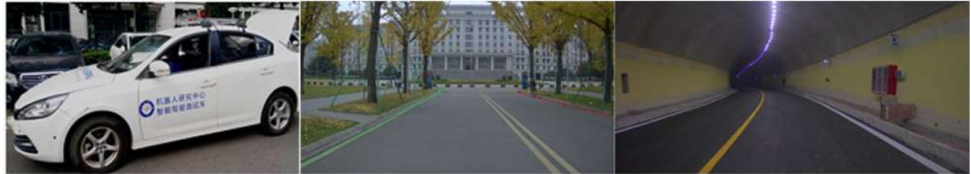
Figure 6. (Top left–bottom right) Experimental equipment, sensor layout, campus scene, Longchi tunnel scene.